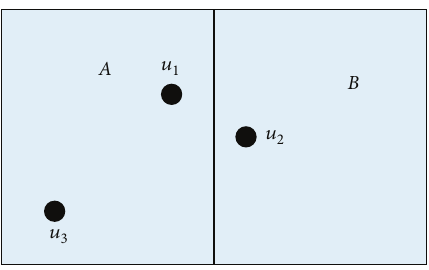
Figure 1: Illustration of localization